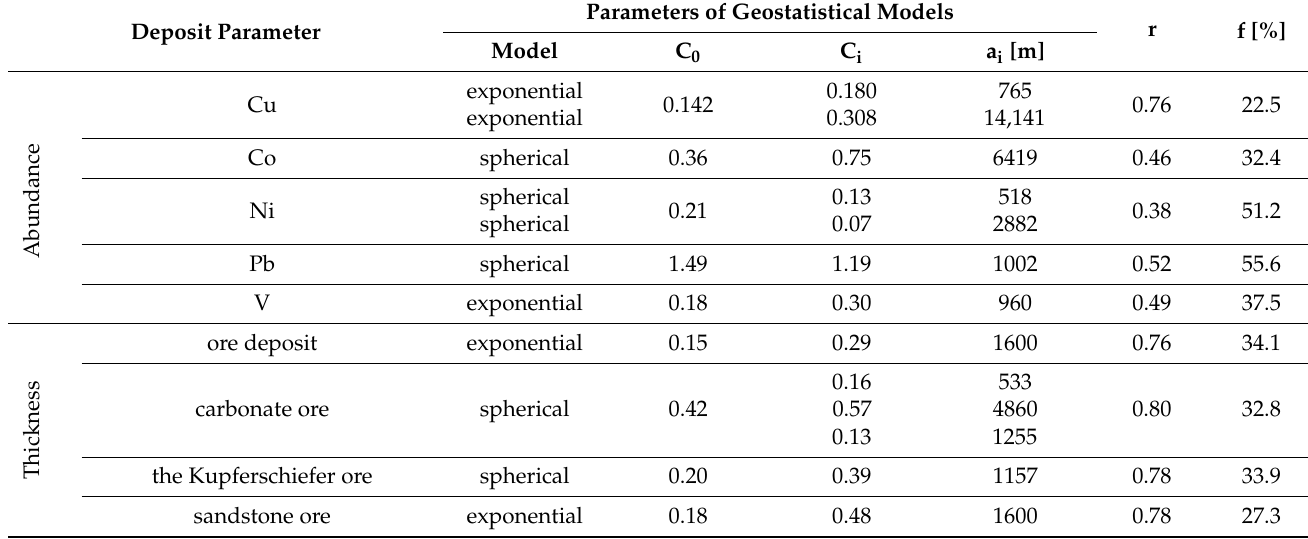
Figure 7. Variogram of Pb abundance before removing the outlier ( a ). Variogram cloud ( b ). Location of sampling points ( c ). Variogram of the Pb abundance after removing the outlier ( d ). Explanations: the values of the variogram related to the outlier value of Pb abundance ( b ) and the pairs of sampling points included in their calculation ( c ) are marked in blue; other values of the variogram ( b ) and the sampling points included in their calculation ( c ) are marked in green; red color—outlier of the Pb abundance ( c ). Table 4. Equations of geostatistical relative models (omnidirectional) of deposit parameters (copper abundance, abundance of accompanying elements, thickness) in the Cu-Ag Rudna